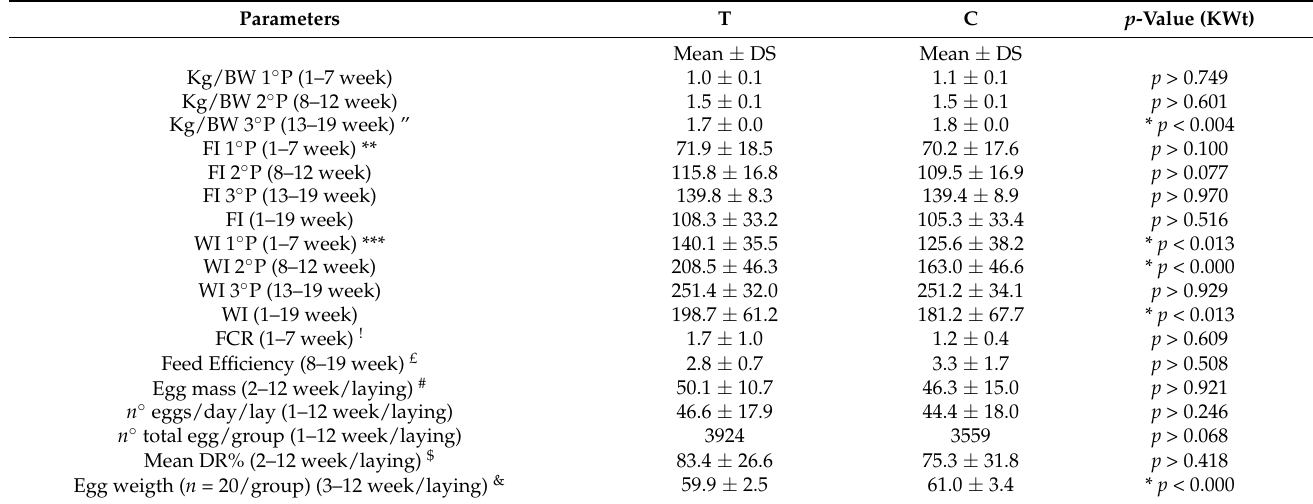
Table 2. Summary of the evaluations of the performance parameters.